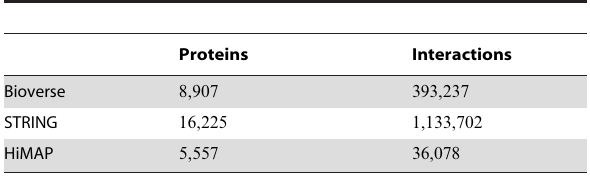
Table 1. Number of proteins and interactions in different